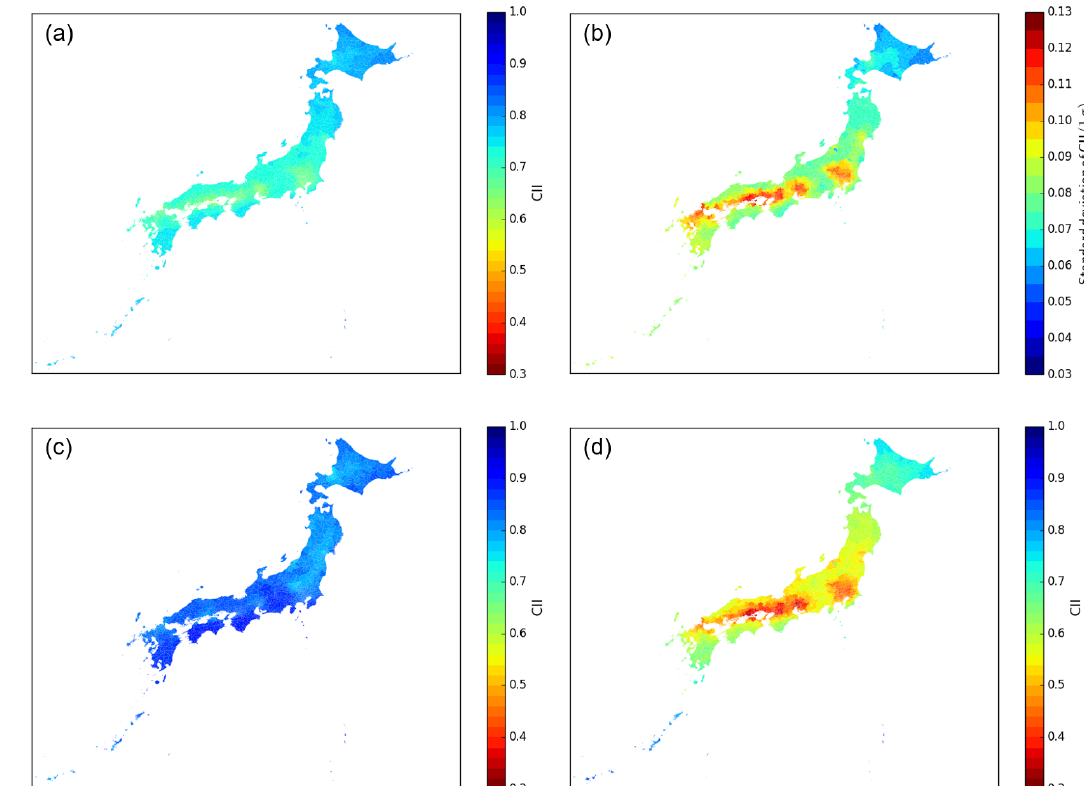
Figure 8. Spatial distributions of CII derived from the WRF–CMAQ model. (a) Mean over the study period (FY 2014–2016). (b) Same as (a) but for standard deviation (1 σ ). (c) Mean for 30d of the highest CII average in all Japanese municipalities (10d from each FY). (d) Same as (c) but for lowest CII